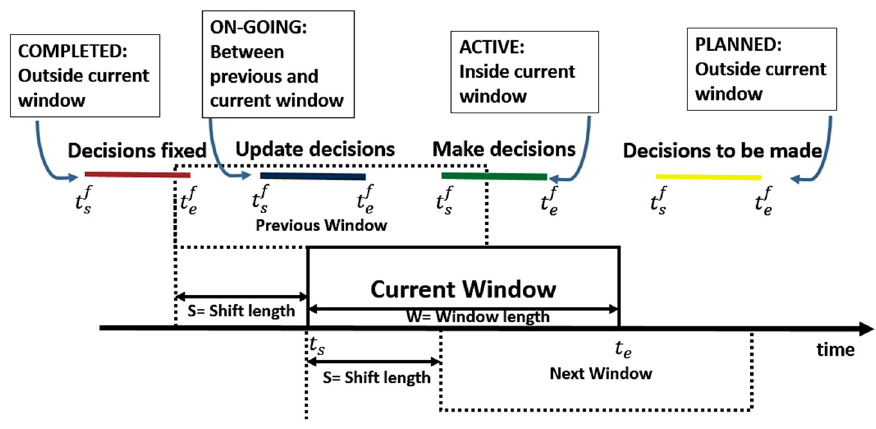
Figure 6. Sliding window approach visualization. © 2021 IEEE. Reprinted, with permission, from [7].